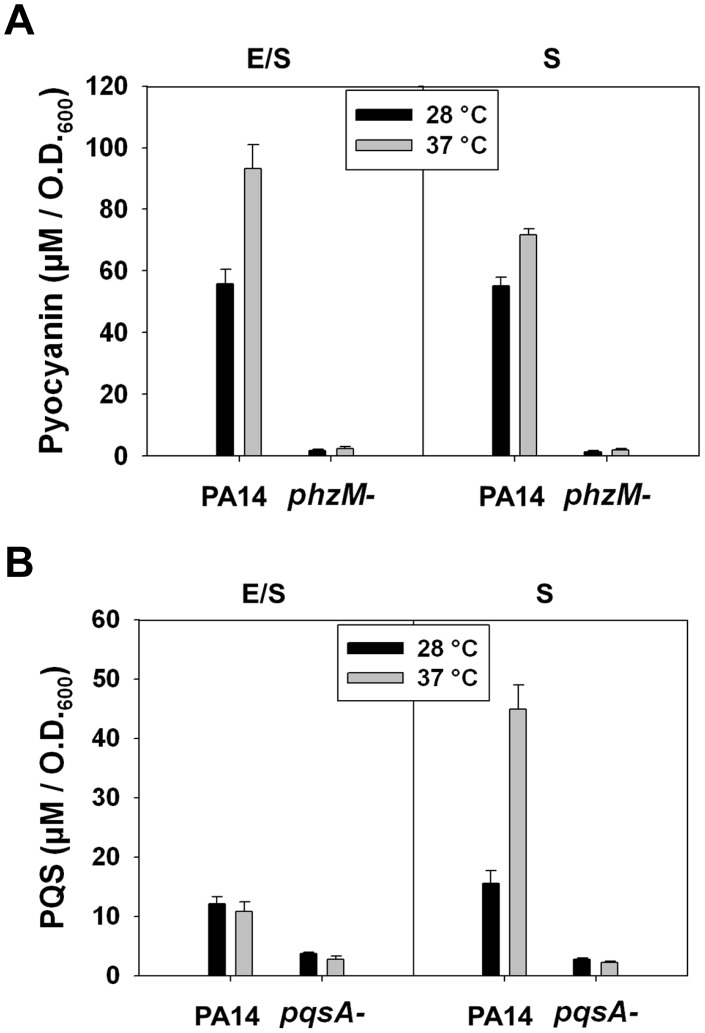
Effect of temperature on production of pyocyanin and PQS.The growth kinetics of cultures of P. aeruginosa PA14 were monitored at O.D.600. The levels of pyocyanin (A) and PQS (B) were determined at 28°C and 37°C at the time of transition from exponential to stationary phase (E/S) and at stationary phase (S). Similarly grown cultures of P. aeruginosa ΔphzM and ΔpqsA were used as negative controls for pyocyanin and PQS production, respectively.